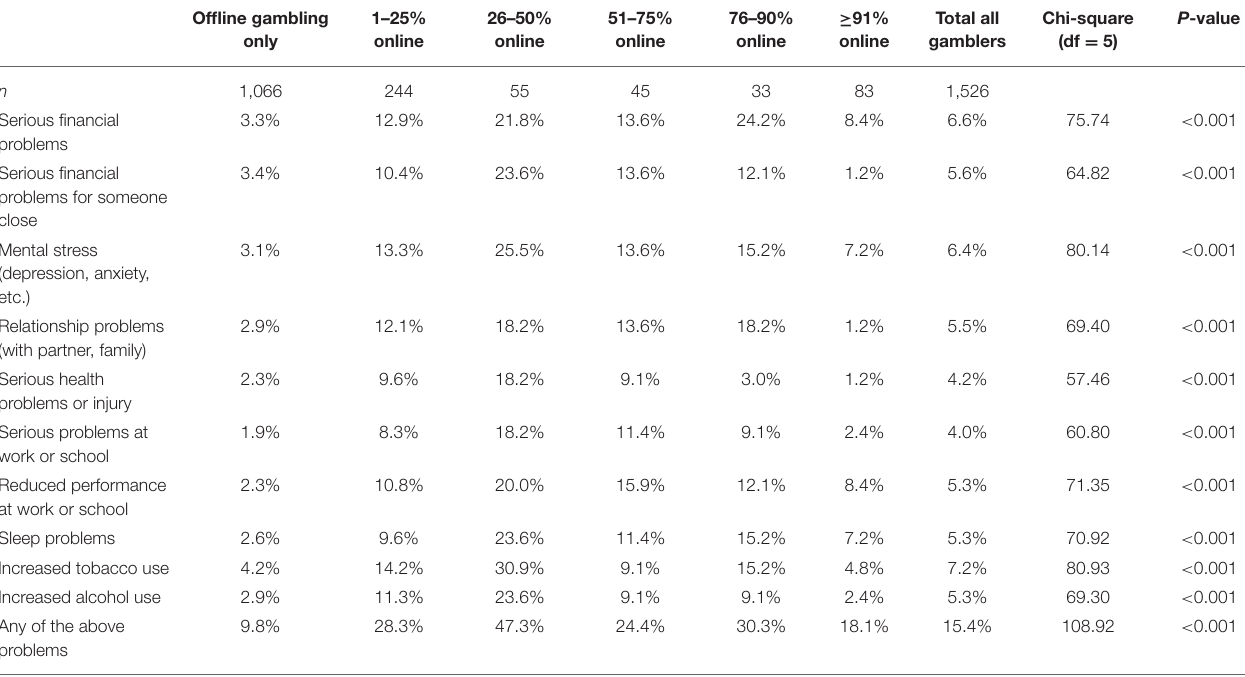
≥ 91% Total all Chi-square online gamblers (df =